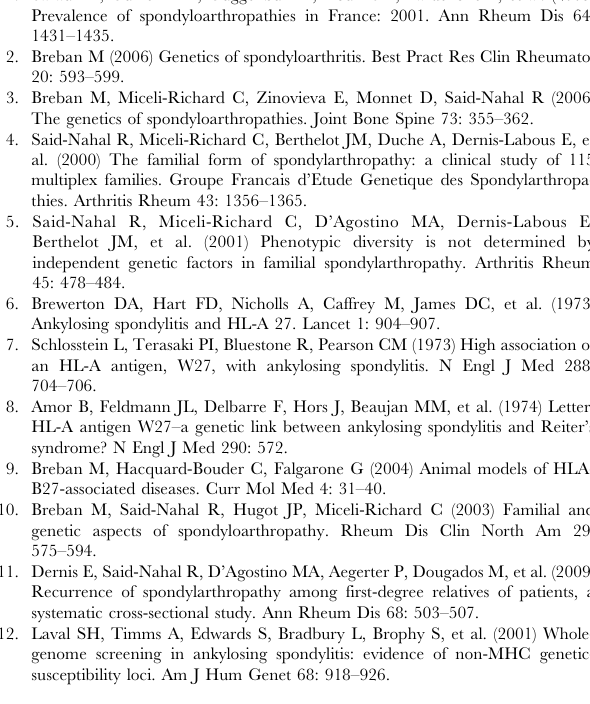
Table S2 Complete results of the family-based association extension study (TaqMan genotyping - 287 families).